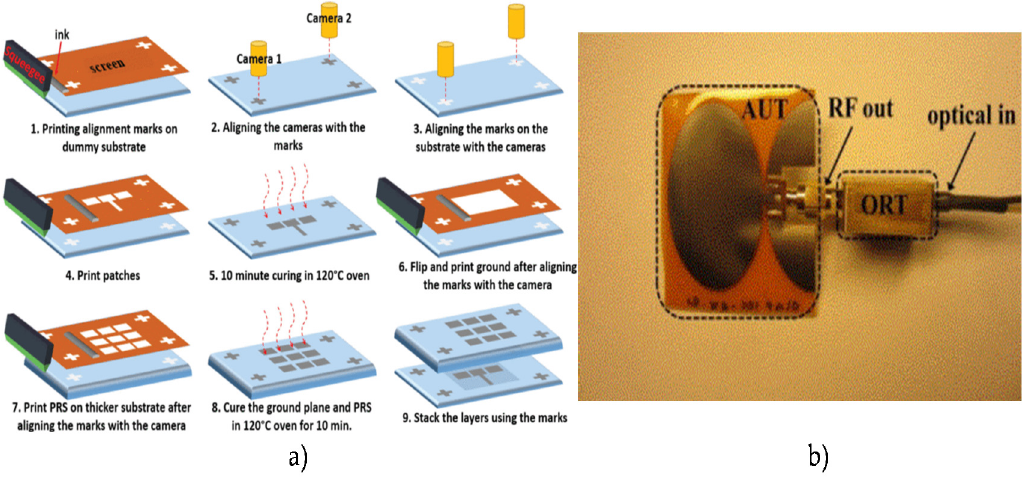
Figure 6. Schematic of the screen-printed antenna. ( a ) Fabrication process for parasitic beam-switching millimeter-wave antenna array [104] and ( b ) screen printed graphene flakes based wideband elliptical dipole antenna prototype [105].